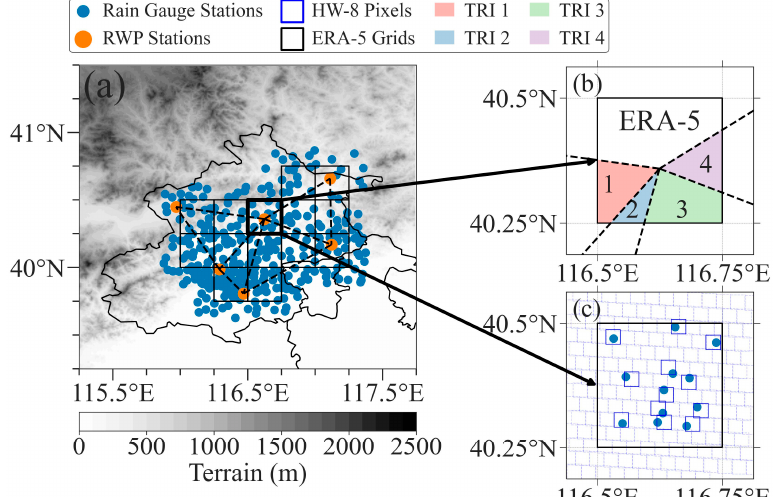
Figure 1. Spatial distribution map of rain gauge stations, radar wind profiler (RWP) stations, Himawari-8 (HW-8) satellite pixels, and ERA-5 reanalysis grids in the study area. ( a ) is the spatial distribution diagram of rain gauge stations and RWP stations in the study area, where blue dots represent rain gauge stations, orange dots represent RWP stations, black dotted lines represent triangular boundaries formed by three RWP stations, and the solid square grid represents an ERA-5 grid with the weight of RWP observational data (described in Section 2.3) greater than or equal to 10%. ( b ) is the spatial matching diagram of the triangle network of the RWP and ERA-5 grid, where the black solid line represents the boundary of the ERA-5 grid and the color-shaded parts represent the overlapping parts of the triangle composed of different RWP and the ERA-5 grid. ( c ) is the spatial matching diagram of the rain gauge station (solid blue dot) and Himawari-8 (HW-8) satellite pixel (blue box).